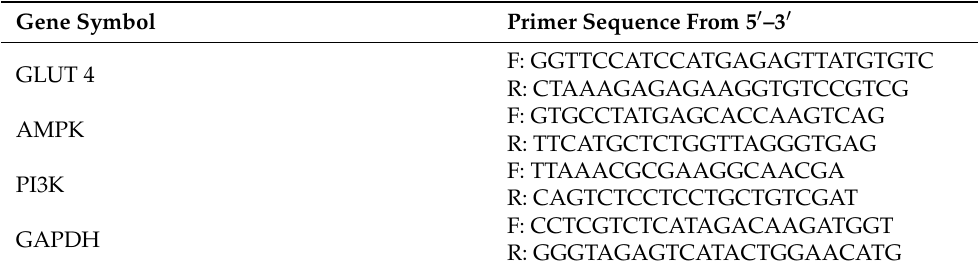
Table 3. Primer sequences of all the studied